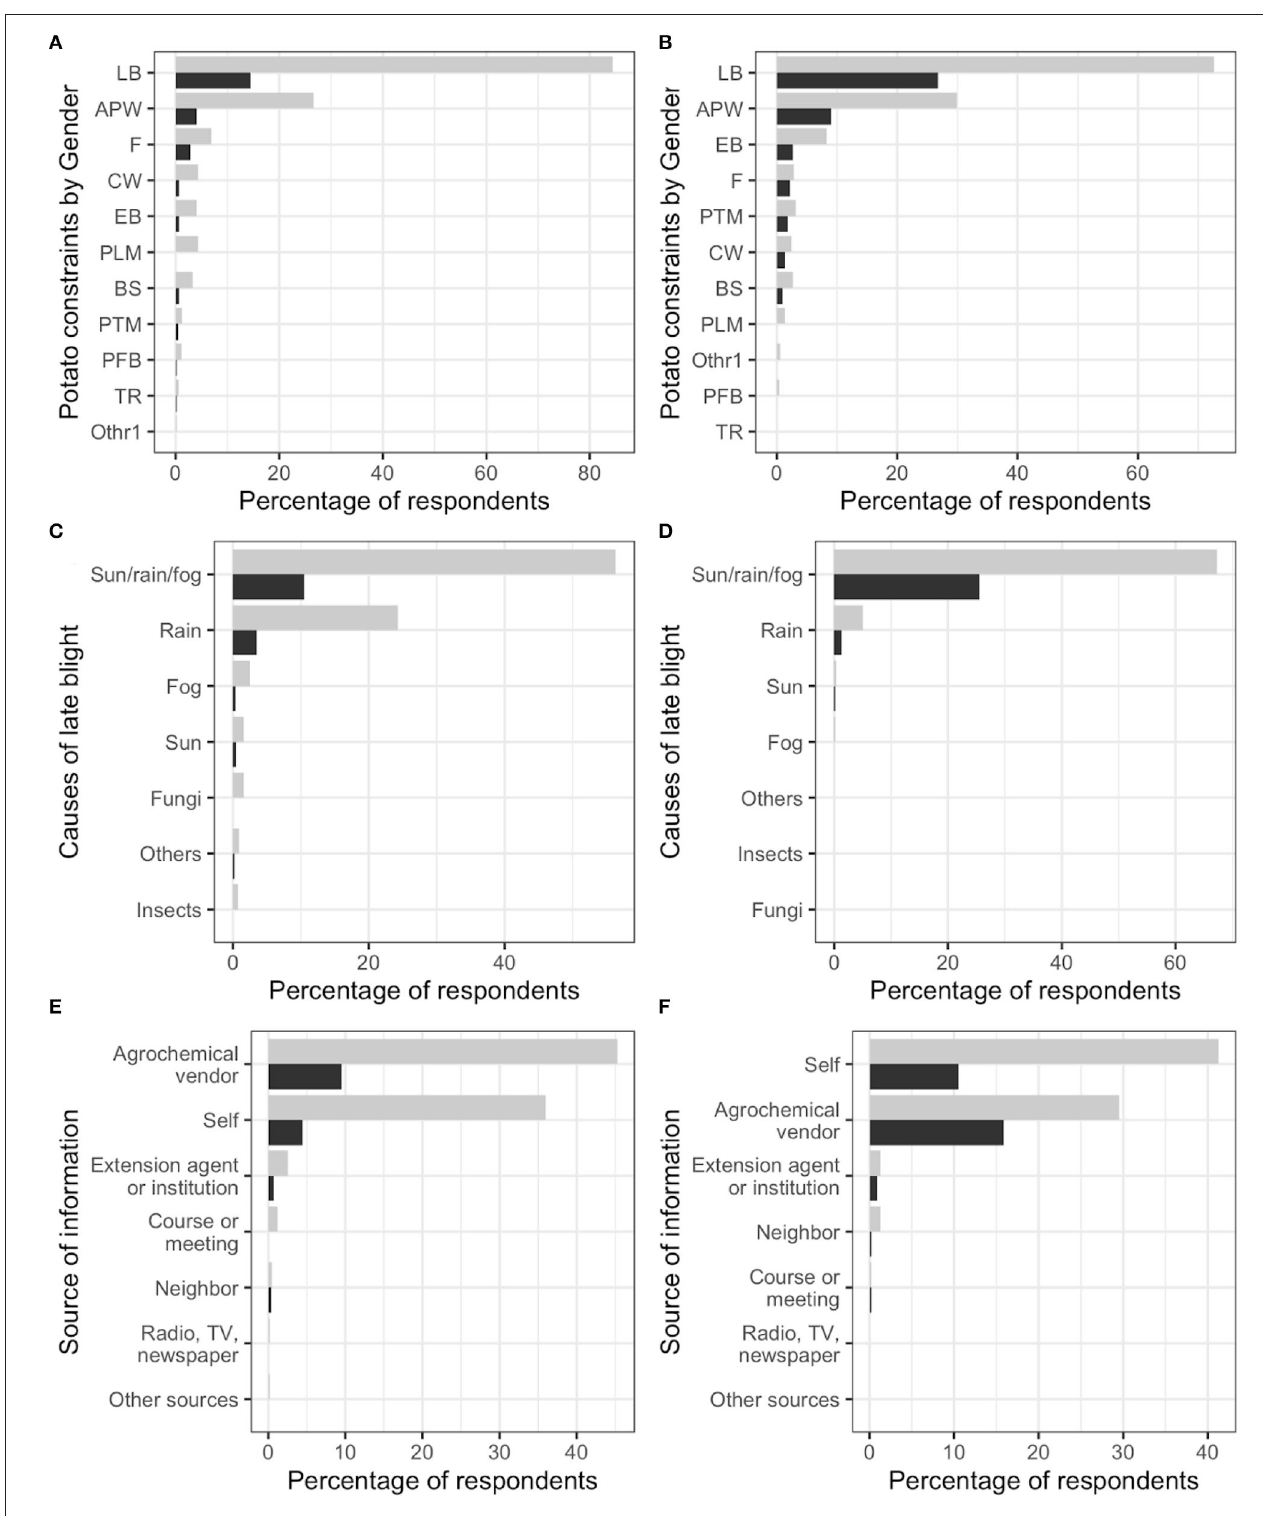
FIGURE 3 | Effects of gender on the most important constraints (A,B) , factors causing late blight (C,D) and sources of information (E,F) in the communities of Paucartambo (A,C,E) and Ulcumayo (B,D,F) . Gray bars represent men and black bars represent women. Fisher’s exact tests of independence indicated that there was no effect of gender for important constraints nor causes of late blight in either location, while for source of information, gender was not significant in Paucartambo ( p = 0.1085) and highly significant in Ulcumayo ( p < 0.001).